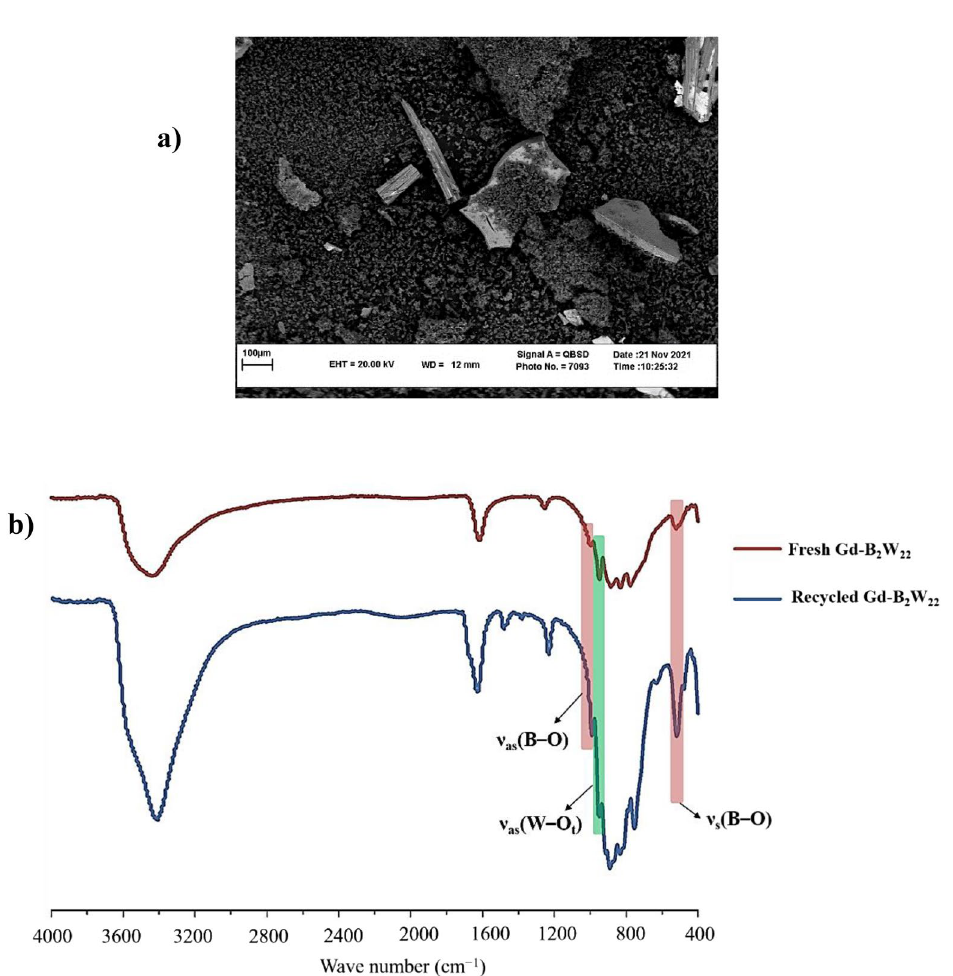
Figure 11. ( a ) SEM image of recycled nano- Gd-B 2 W 22 ; ( b ) FTIR overlay of the fresh and recycled nano- Gd-